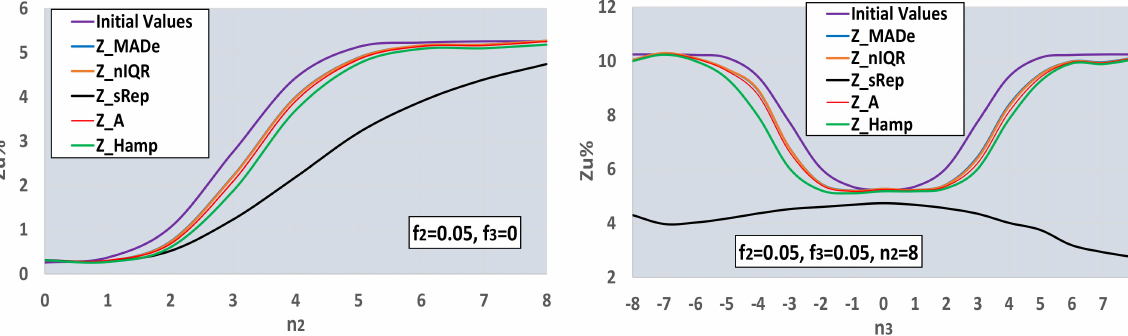
Figure 8. Function between Zu% and number of standard deviations n 2 , n 3 , and N lab = 400. Calcula- tion of initial values using step (iv) of Section